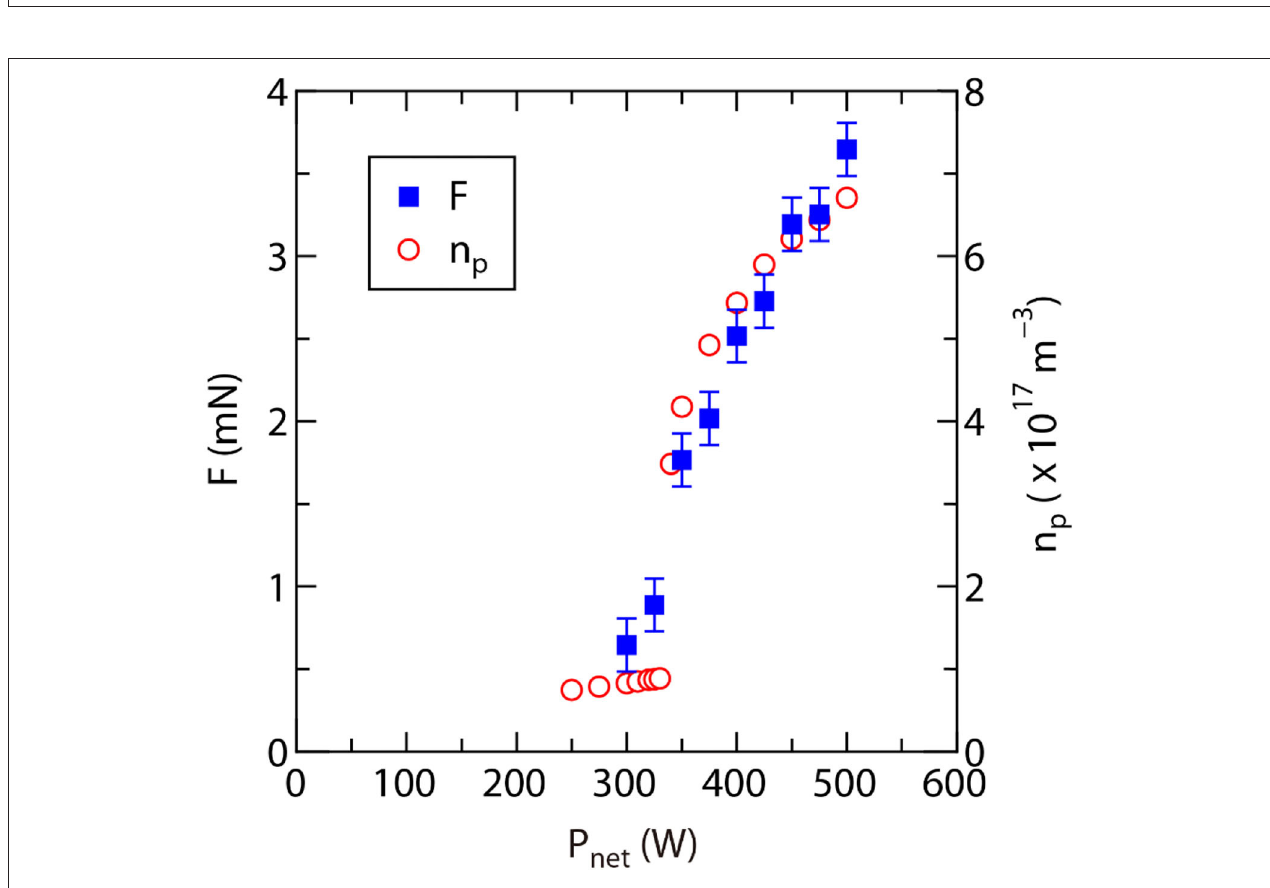
FIGURE 6 | Thrust F measured by the thrust balance and plasma density n p taken at z = − 10cm as functions of the net power P net .